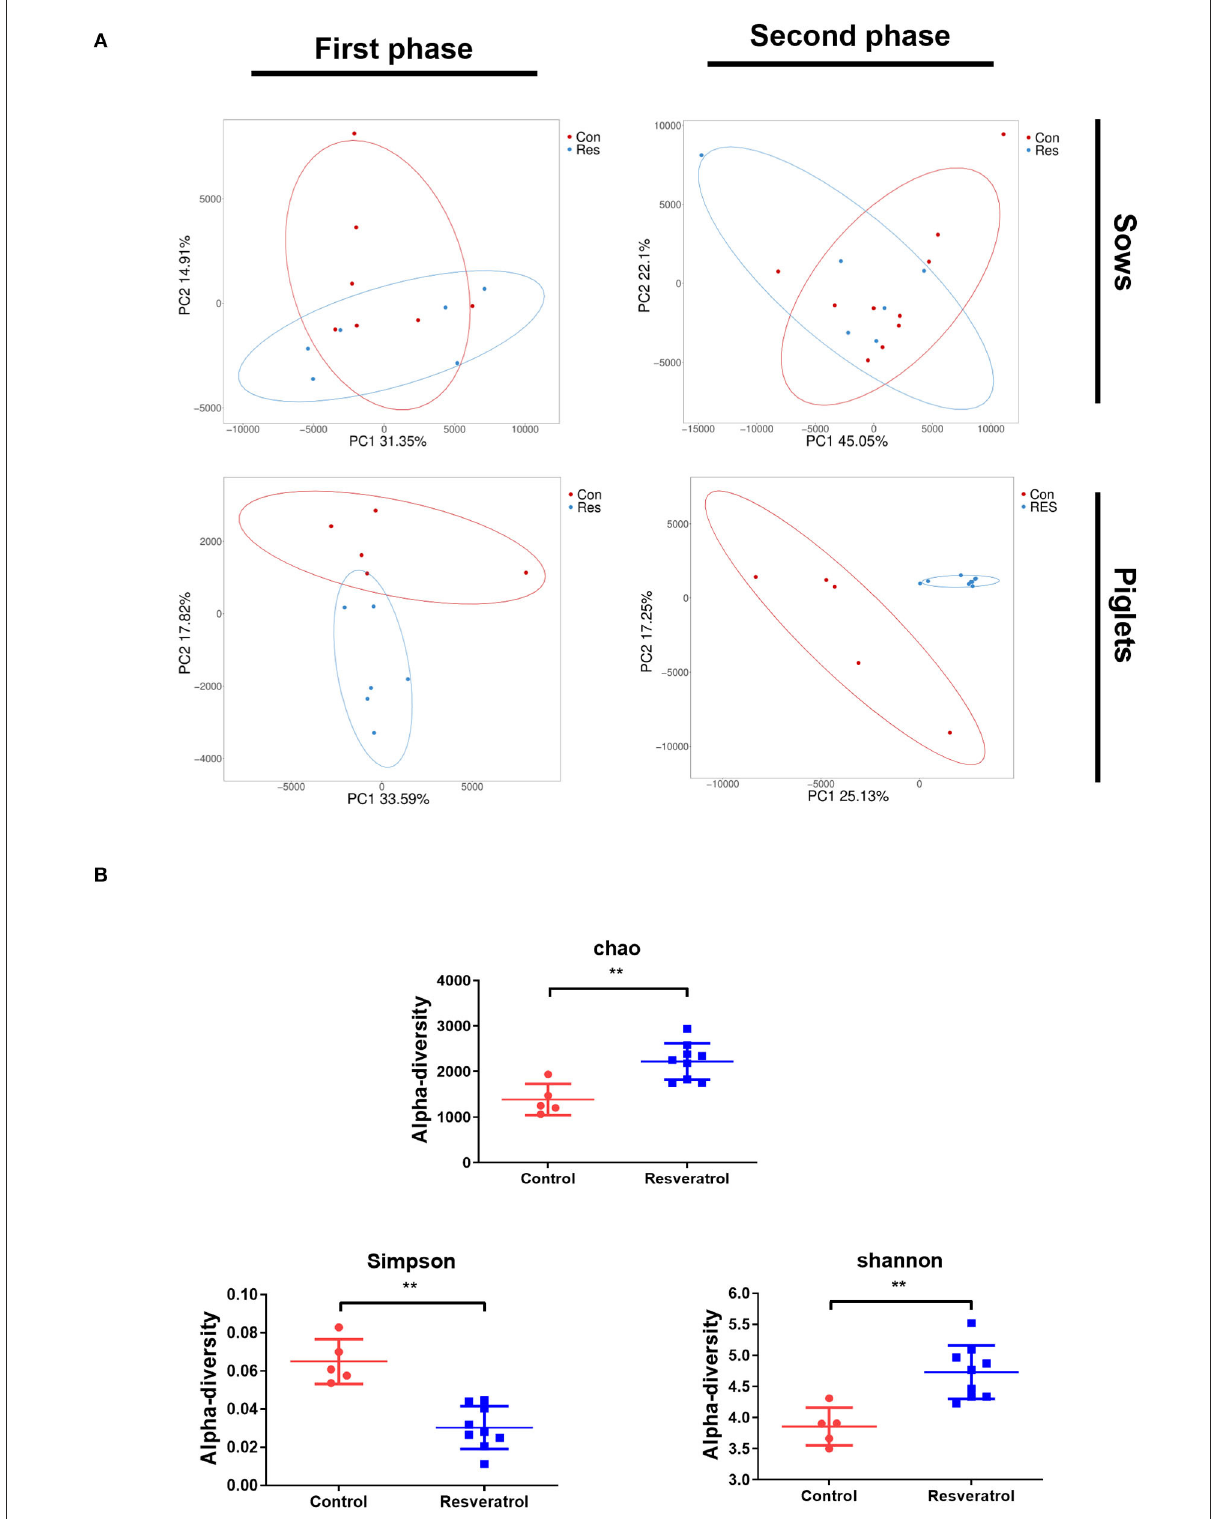
FIGURE5 (A) Intestinal microbiota composition of sows and piglets by principal component analysis (PCA) analysis. Con, control treatment; Res, resveratrol treatment. (B) Intestinal microbiota composition of sows and piglets by α -diversity analysis. Data were expressed as means ± SEM of at least three independent experiments. ** p <